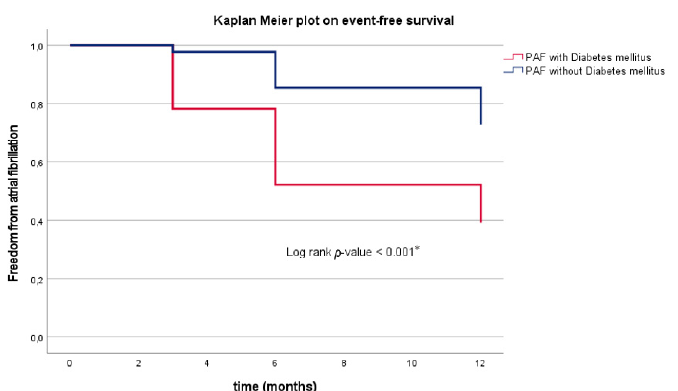
antidiabetic therapy and AT/AF recurrence freedom, neither in PAF ( p = 0.098) nor in PERS ( p = 0.070).